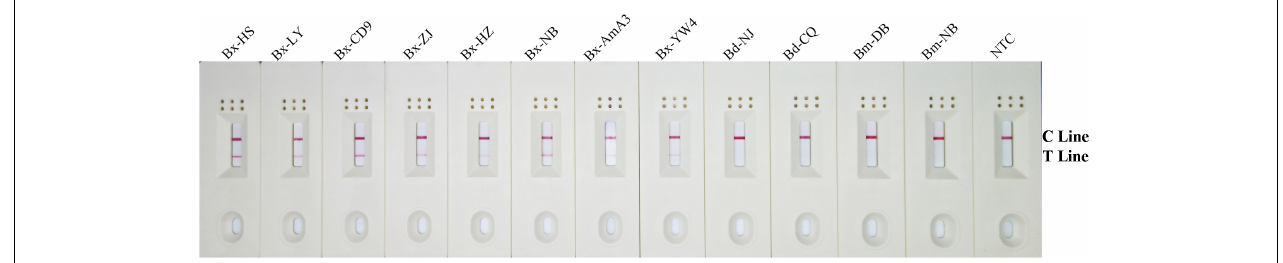
FIGURE 7 | Detection of B. xylophilus purified gDNA in spiked pinewood samples. Images of the LFD results of RPA amplification of healthy pinewood samples spiked with gDNA of various nematode isolates. The spiked gDNA species are shown at the top of each dipstick. The double-distilled water was used as the no-template control, corresponding to the NTC dipstick. The positions of the control and test lines are shown on the right side of the image. The reactions are carried out at 38 ◦ C for 10 min.